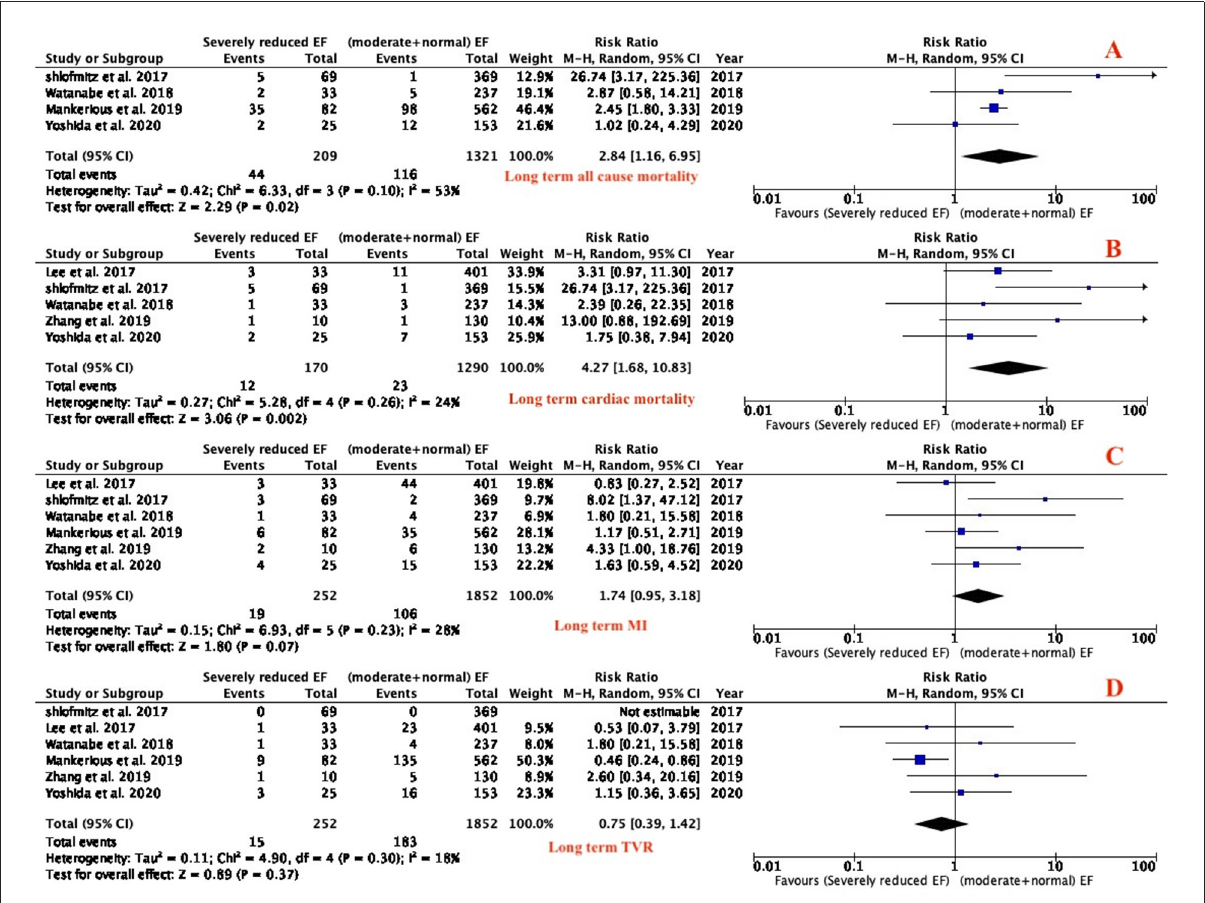
FIGURE3 Forest plot of long term outcomes (all-cause mortality, cardiac mortality, MI, TVR). (MI, myocardial infarction; TVR, target vessel